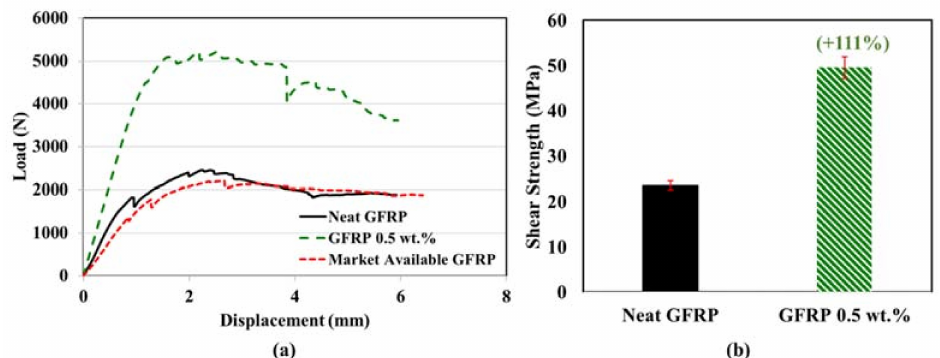
Figure 11. Short beam shear test for horizontal shear strength of pultruded GFRP: ( a ) representative load–displacement behavior of the neat GFRP, GFRP including 0.5 wt.%, and a market-available GFRP bar with 9.5 mm diameter; ( b ) comparison of horizontal shear strength. The percentage shown above the error bar represents the improvement in horizontal shear strength of pultruded GFRP bars incorporating COOH-MWCNTs.